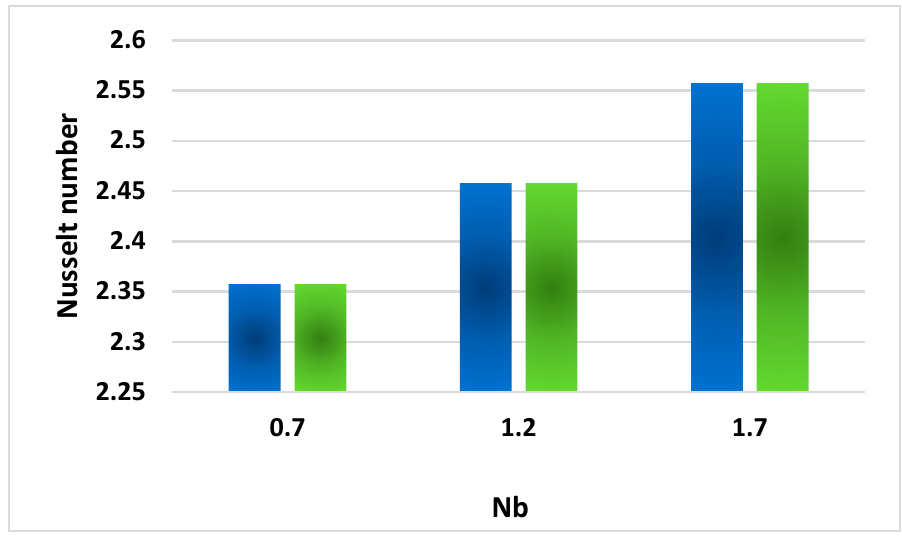
Figure 19. Revealing the consequences of Nb related to the Nusselt number. Figure 16 displays the impact of the Prandtl number Pr on the drag coefficient. The Prandtl number is the dimensionless quantity expressing the ratio of momentum diffusivity to the thermal diffusivity. Momentum diffusivity is the dynamic viscosity to fluid density ratio, and thermal diffusivity expresses the ratio of thermal conduction to density and specific heat. Viscosity is inversely related to temperature. A decrement in temperature depreciates thermal diffusivity and moreover strengthens the fluid viscosity and momen- tum diffusion phenomenon. That is why a positive variation in Pr magnifies the fluid velocity and surface drag phenomenon. The effect of unsteady parameter A on the surface drag coefficient is highlighted in Figure 17. Velocity is inversely related to the surface drag phenomenon. Note that the fluid velocity decreases as a result of a magnification in A . The fluid is almost impossible to move due to an increment in A, which depreciates the fluid velocity and amplifies the surface drag phenomenon because the velocity of the fluid flow is inversely linked with the drag phenomenon. Figure 18 is designed to explore the effect of magnetic parameter M on the surface drag coefficient. Electrical conducting fluid when passing through electric and magnetic fields produces a force called Lorentz force. Lorentz force is basically a resistive force. Lorentz force acts like a barrier in